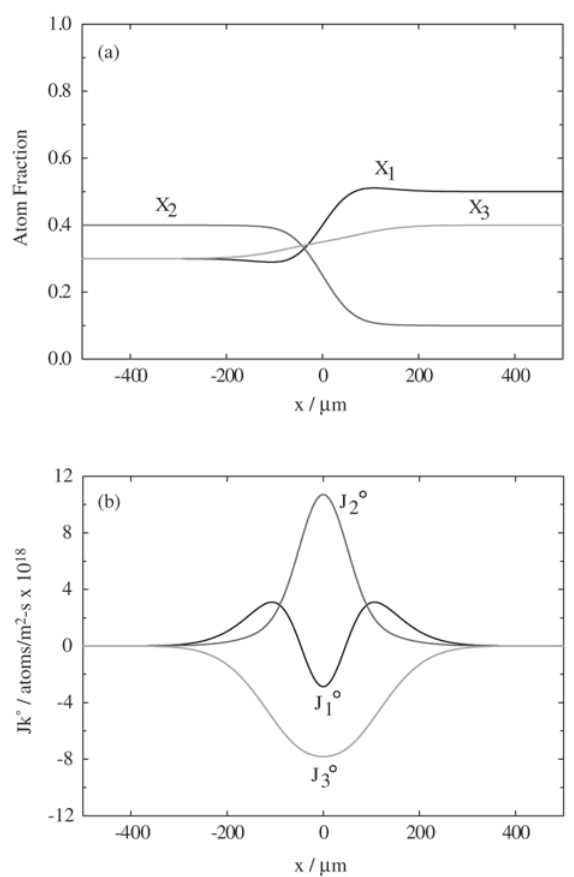
Figure 3. Calculation of the interdiffusion flux directly from the concentration profiles using Dayananda’s equation 5 . a) concentra- tion profiles; b) interdiffusion fluxes.